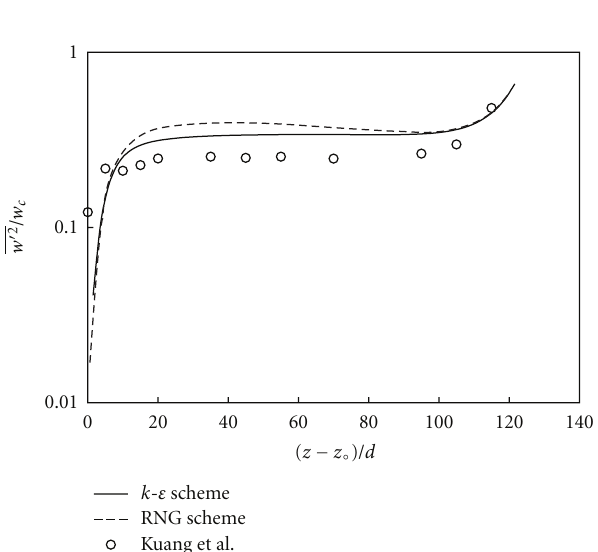
Figure 5: Profiles of longitudinal velocity in ZFE.